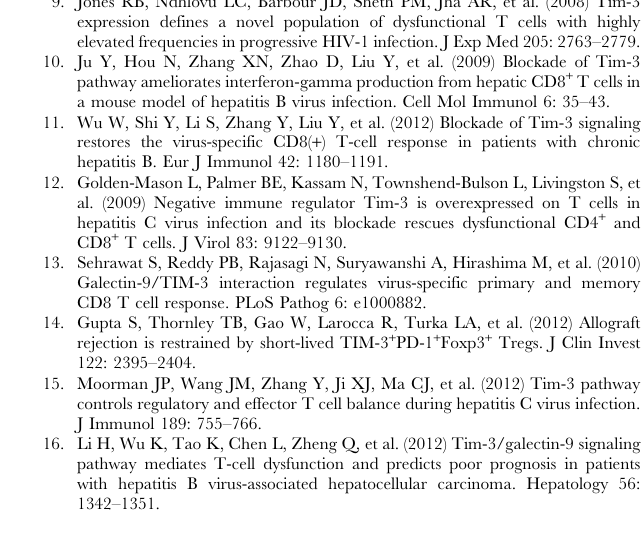
Figure S6 Frequency of Foxp3 expression in Tim-3 single positive (Tim-3 SP), Tim-3 and PD-1 double positive (DP), PD-1 single positive (PD-1 SP), and Tim- 3 and PD-1 double negative (DN) CD4 T cell subsets from non-tumor-infiltrating lymphocytes (NIL, n = 4) and tumor-infiltrating lymphocytes (TIL, n = 4) isolated from HCC patients. Bars indicate the SEM; *, P , 0.05; **, P , 0.01; ***, P , 0.001. (TIF) Figure S7 Expression of CTLA-4, GITR and PD-1 in Tim-3 + Foxp3 + and Tim-3 2 Foxp3 + CD4 T cells. Tumor- infiltrating lymphocytes were first gated on CD4 + Foxp3 + T cells. Expression of CTLA-4, GITR and PD-1 were compared between Tim-3 + Foxp3 + and Tim-3 2 Foxp3 + CD4 T cells. FACS images are representative of 4 samples. Bars indicate the SEM; *, P , 0.05; **, P , 0.01. Table S1 Clinical characteristics of the four colon cancer patients. Table S2 Clinical characteristics of the three cervical cancer patients. Table S3 Clinical characteristics of the three ovarian cancer patients. Table S4 Fluorochrome-conjugated antibodies used in flow cytometry. Table S5 Correlation between Tim-3 + Tregs and TNM stages in